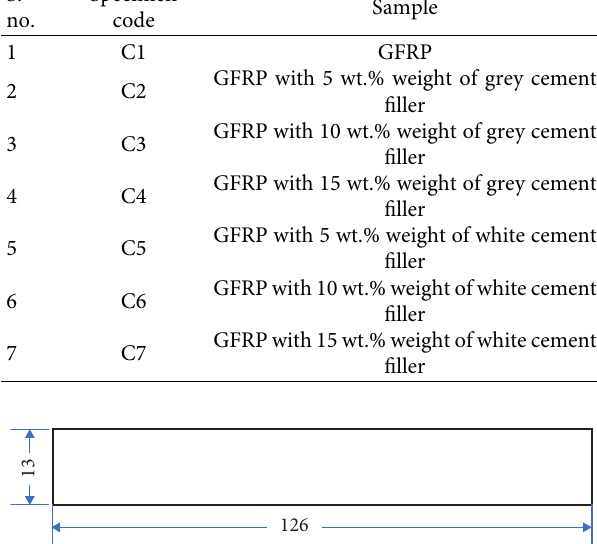
Figure 1: Flexural test specimen dimensions as per ASTM D790.